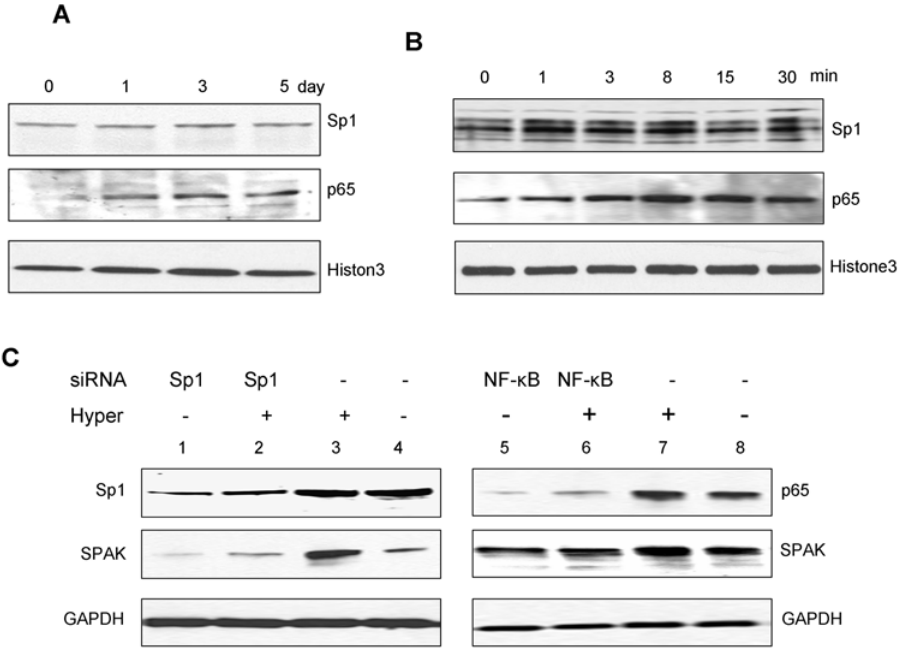
Figure 7. Western blots of transcription factors Sp1 and NF- k B (p65). A. Western blots of Sp1 and NF- k B (p65) demonstrating hyperosmolarity effect on Sp1 and NF- k B protein levels in vivo . Histone3 acts as a control. B. Western blots of Sp1 and NF- k B (p65) demonstrating hyperosmolarity effect on Sp1 and NF- k B protein levels in vitro . Histone3 acts as a control. C. Reduction of NF- k B but not Sp1 expression reduced SPAK protein expression in unstimulated and in hyperosmolarity-stimulated Caco2-BBE cells. Cells were harvested and subjected to western blot